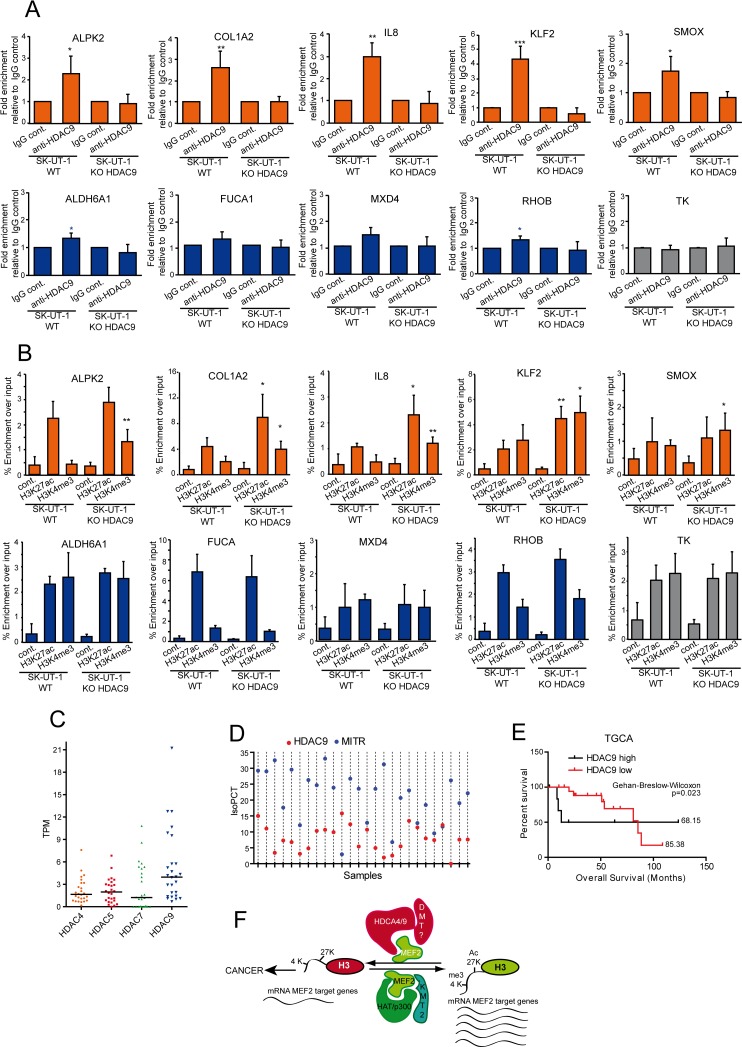
Epigenetic changes monitored by HDAC9.A) ChIP in SK-UT-1 cells WT or KO for HDAC9. Chromatin was immunoprecipitated using the anti-HDAC9 antibody. Normal rabbit IgGs were used as control. TK promoter was used as negative control. Atypical MEF2-targets are indicated in orange and the classical ones in blue. The genomic regions amplified by qPCR are the same as reported in S5E Fig. Data are presented as mean ± SD; n = 4. B) ChIP in SK-UT-1 cells WT or KO for HDAC9. Chromatin was immunoprecipitated using the anti-H3K27ac and the H3K4me3 antibodies as indicated. Normal rabbit IgGs were used as control. TK promoter was used as negative control. Atypical MEF2-targets are indicated in orange and the classical ones in blue. The genomic regions amplified by qPCR are the same as reported in S6A and S6B Fig (for H3H27ac) and in S6A and S6B Fig (for H3K4me3). Data are presented as mean ± SD; n ≥ 4. C) Scatter dot plot representing the coding mRNA TPM levels of the four class IIa HDACs in a cohort of 26 LMS samples. The horizontal lines indicate the median. Dunn's Multiple Comparison Test was applied to test the significance of HDAC9 up-regulation. D) Scatter dot plot representing the IsoPCT of the two main isoforms of HDAC9: HDAC9 WT (red) and MITR (blue). Individual tumors (n = 26) were aligned along the x axis. E) Kaplan-Meier survival analysis related to the expression levels of HDAC9, performed on the same samples and according to the same criteria as in Fig 1H. F) Summary of the shift in MEF2 transcriptional activities in relation to tumor progression in LMS. Possible co-activators and co-repressor are illustrated. The scheme describes the condition for the atypical MEF2-targets only. * p < 0.05, ** p < 0.01, *** p < 0.001.